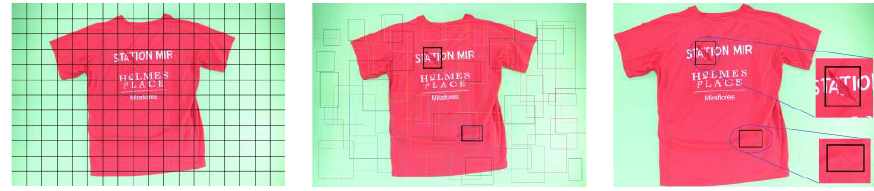
Figure 24. Intersection over Union — B1: Predication Box and B2: Detection Box (Adapted from [33,34]). Figure 25. Non-Maximum Suppression Process example (Adapted from [33,34]). YOLO is much faster (45 frames per second) than other object detection